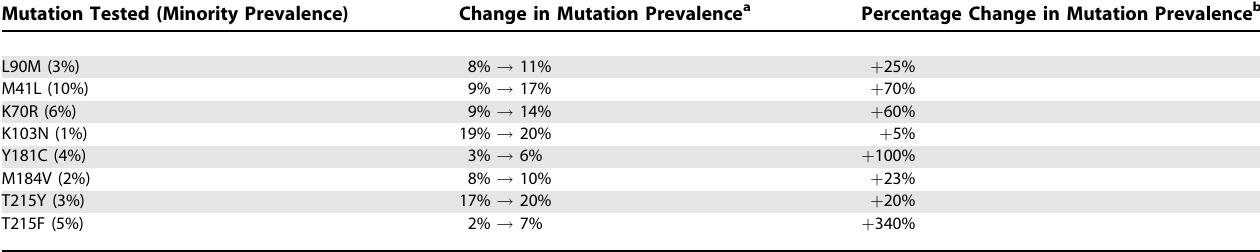
Table 4. Minority Resistance Mutation Prevalence in 303 Mutant Virus Group Samples in the Cross-Sectional Study of Individuals from the US (1997–2005) and Canada (2000–2001), and the Observed Increase in Prevalence for Each Mutation when Minority Variants Are